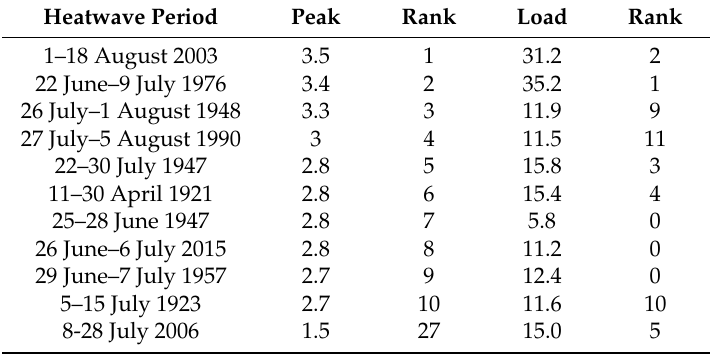
Table 7. Heatwave event peak and load using severity for Paris (Orly Airport, 1921 to 2018). Top 10 ranked for event peak severity. 27th rank inserted. Severity is dimensionless [